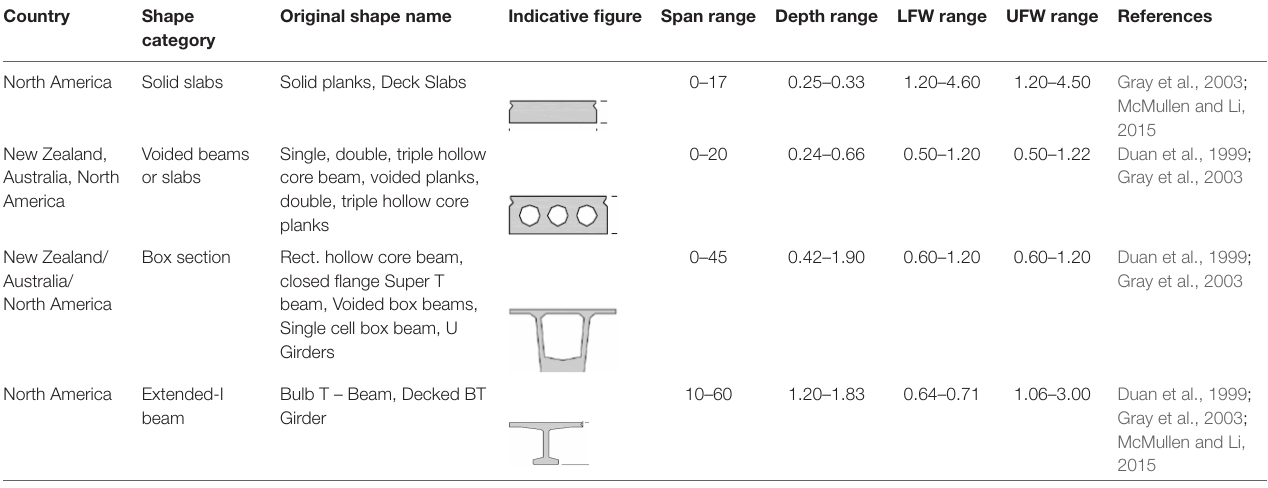
TABLE 1 | Standard beam shapes in different countries (all dimensions in m).